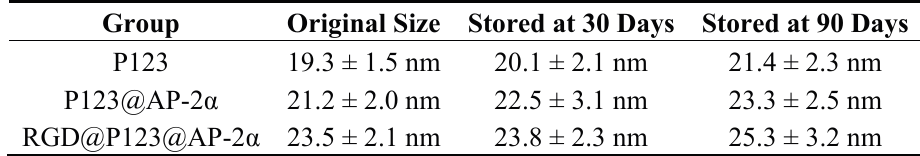
Table 1. Values of different copolymer sizes loaded with RGD or AP-2 α stored at 4 °C for different time intervals, respectively ( n = 16).